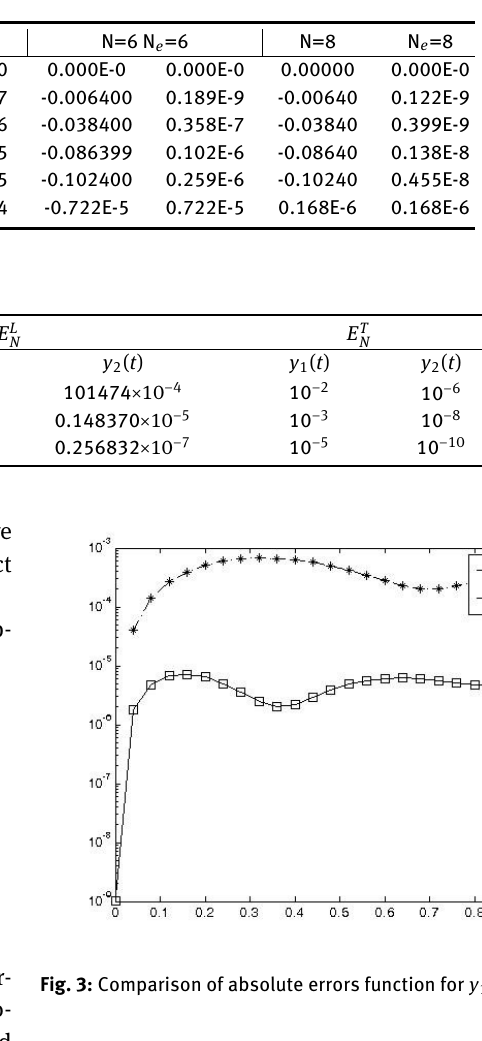
Table 2: Numerical result for approximate solution of y 2 ( t ) in Example 2.